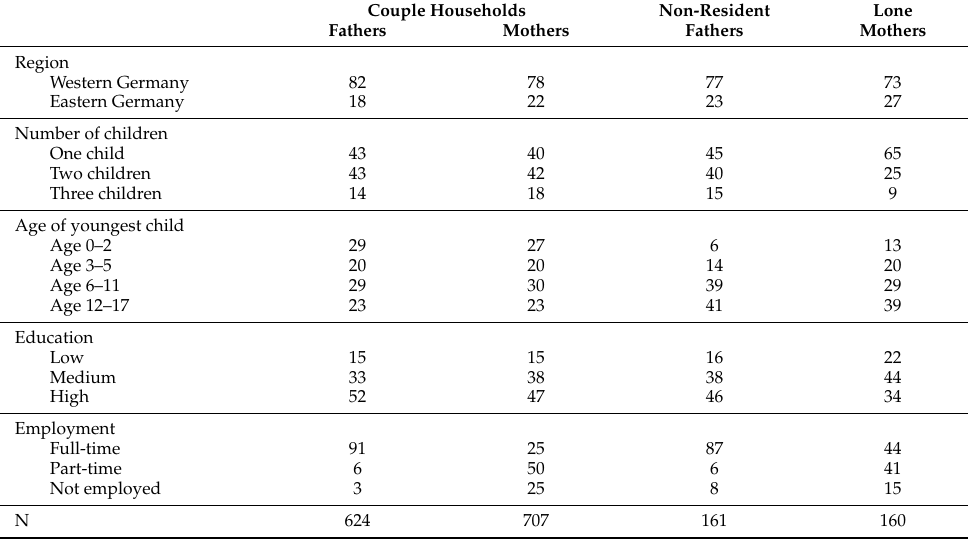
Table 1. Sample statistics by family form (in column